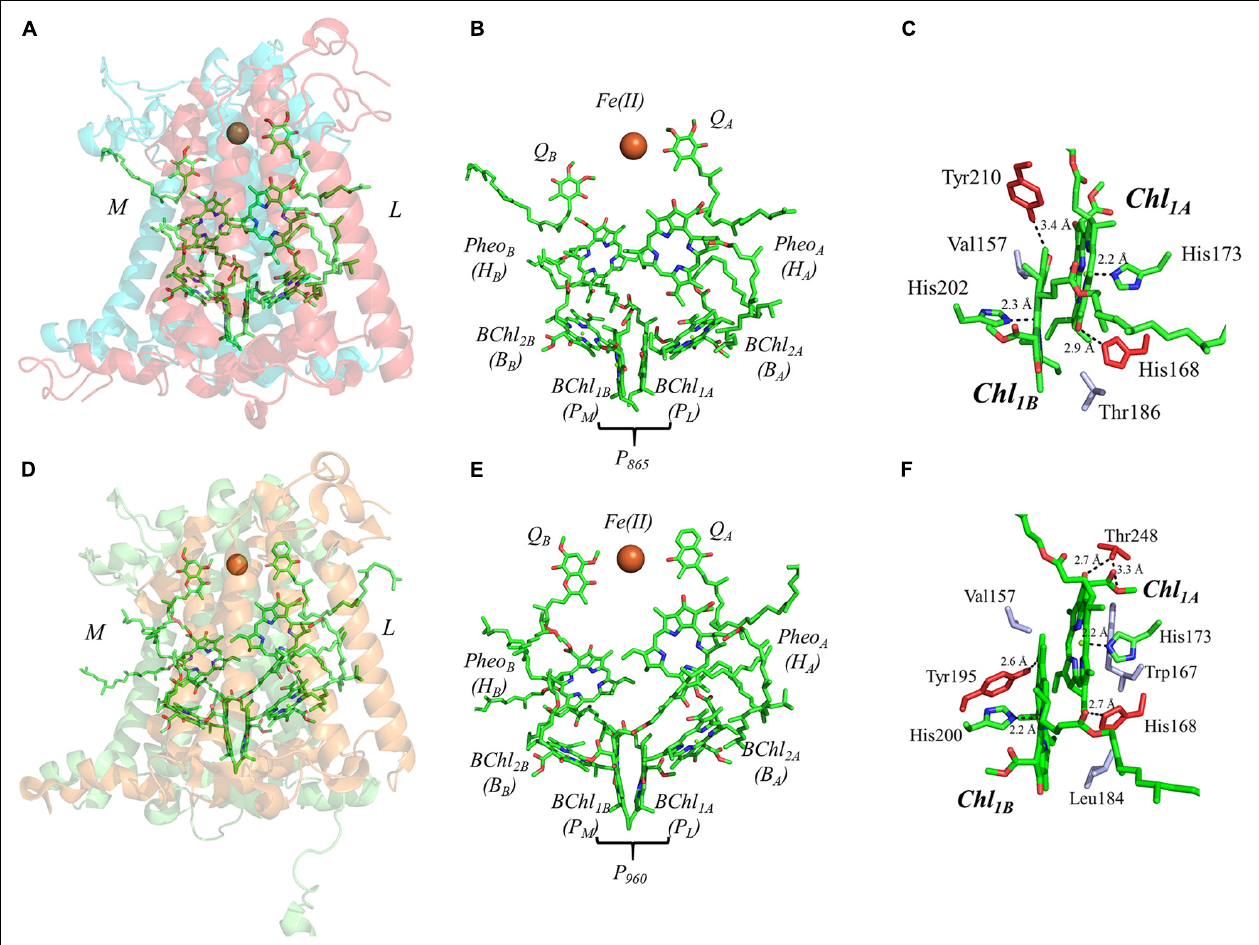
FIGURE 7 | (A) The core subunits (M, blue; and L, red) and cofactors of the bRC from Rba. sphaeroides as observed by X-ray crystallography (PDB ID: 1aij), (B) the cofactors that participate in the primary electron transfer pathway of the bRC from Rba. sphaeroides and (C) the binding pocket of the primary donor, P 865 . (D) The core subunits (M, blue; and L, red) and cofactors of the bRC from Rps. viridis as observed by X-ray crystallography (PDB ID: 2jbl), (E) the cofactors that participate in the primary electron transfer pathway of the bRC from Rps. viridis and (F) the binding pocket of the primary donor, P 960 . Commonly used labels are in parentheses. Part (C,F) emphasize the prominent protein-matrix effects of the primary donor of the bRC from Rba. sphaeroides and Rps. viridis , respectively, where the residues that are hydrogen bonded to the primary donors are shown in red, and nearby non-polar or π -stacked residues are colored in